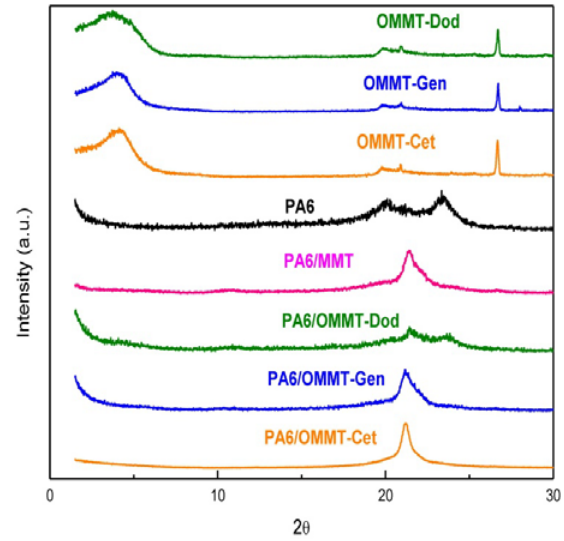
Figure 2. XRD patterns of organoclay, polyamide 6 (PA6) and nanocomposites of